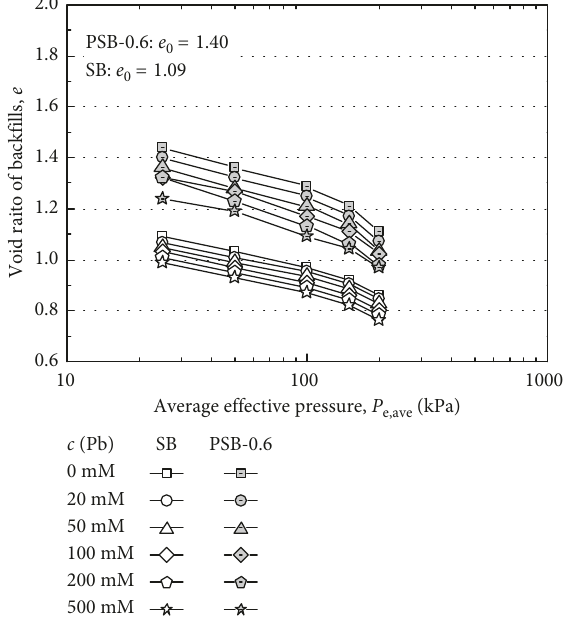
Figure 7: The void ratio ( e ) of backfills and applied